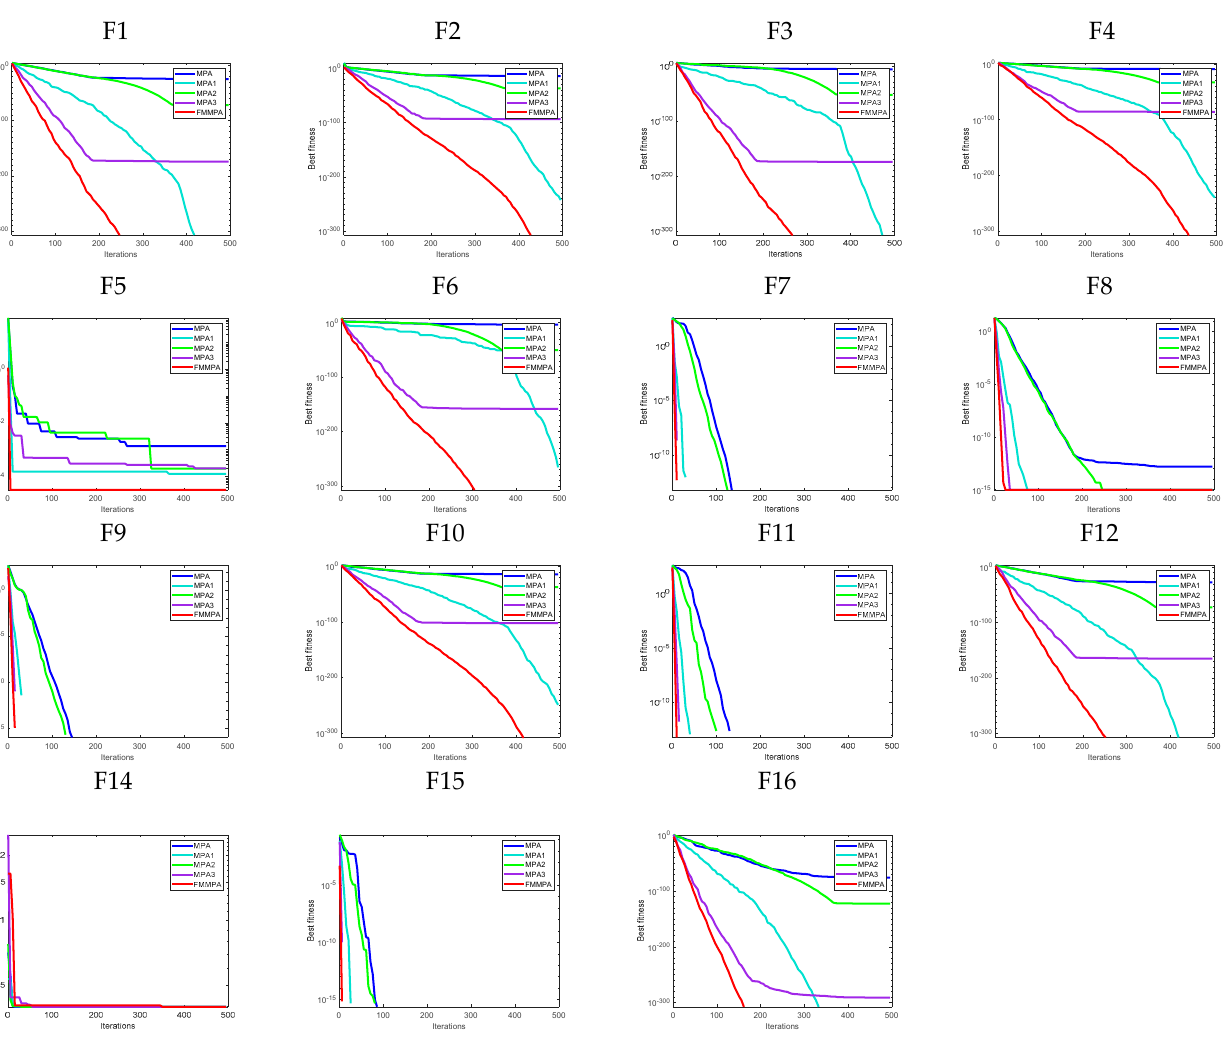
Figure 5. Convergence curves of FMMPA and different strategies.